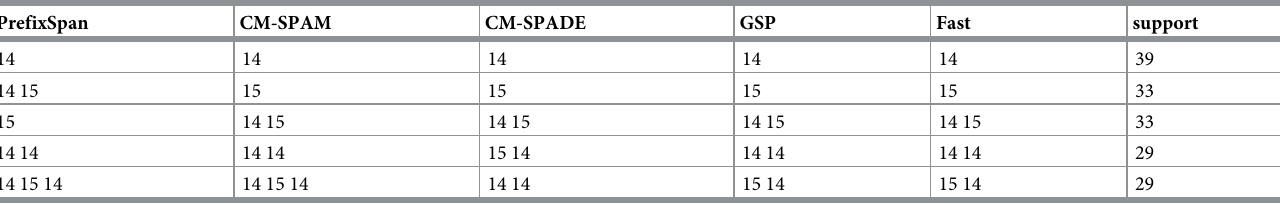
Table 8. Top five PrefixSpan-obtained patterns with the largest support: Conceding+1 dataset. PrefixSpan CM-SPAM GSP Fast